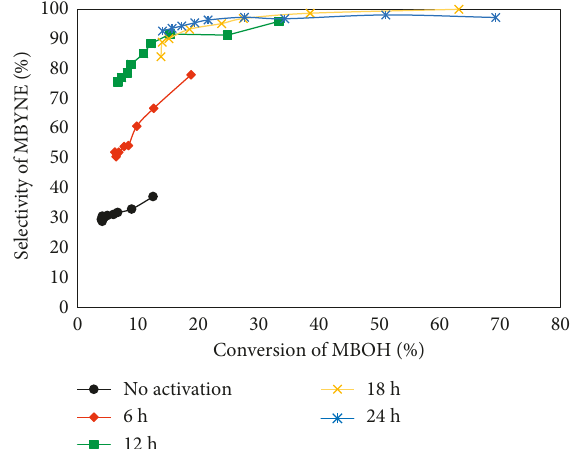
Figure 4: Conversions of the MBOH over grey kaolin heated to 400 ° C, under nitrogen stream, and subjected to different holding times (6 h, 12h, 18 h, and 24 h), at a reaction temperature of 130 ° C.